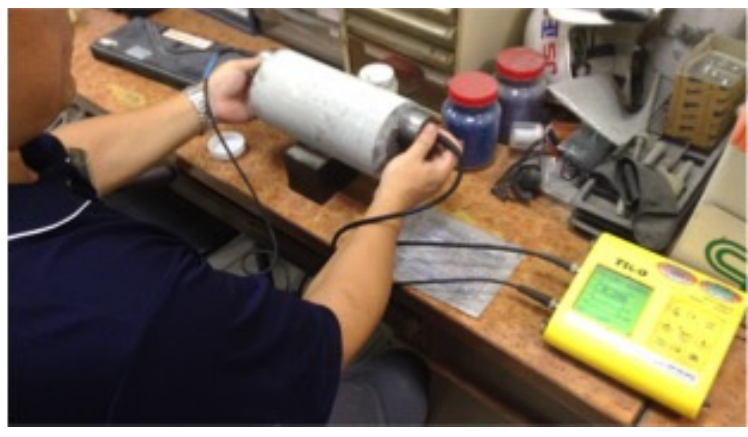
Figure 4. Ultrasonic pulse velocity test.